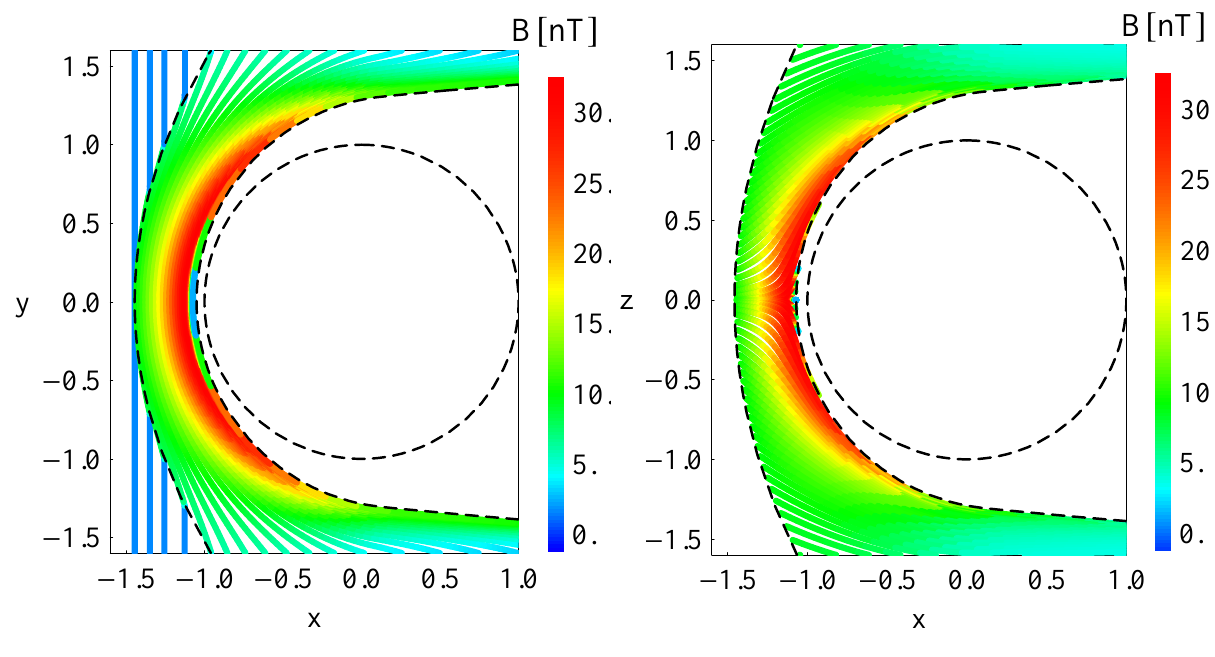
Fig. 6. MHD model: Distribution of the magnetic field strength in the xy plane (left) and xz plane (right).